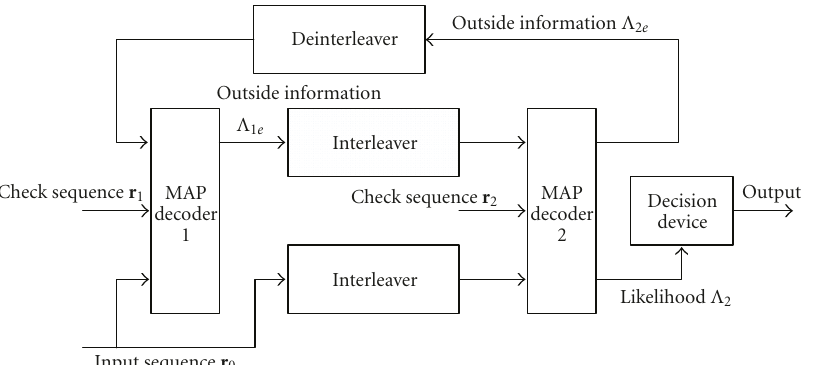
Figure 4: Framework of turbo decoder.